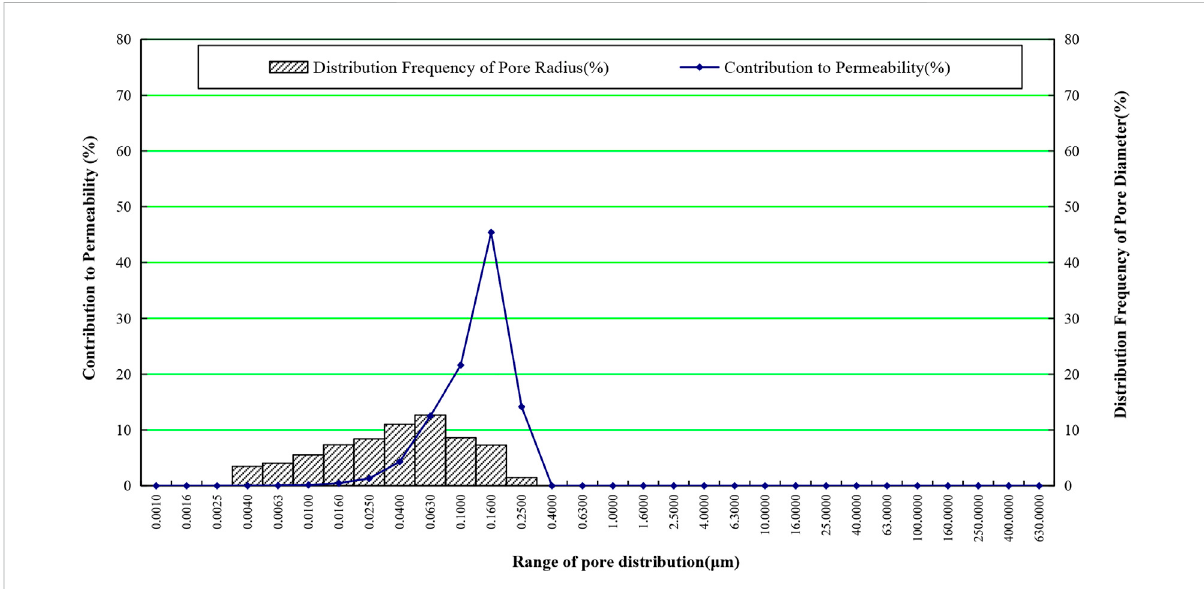
FIGURE 1 Pore diameter distribution and contribution to